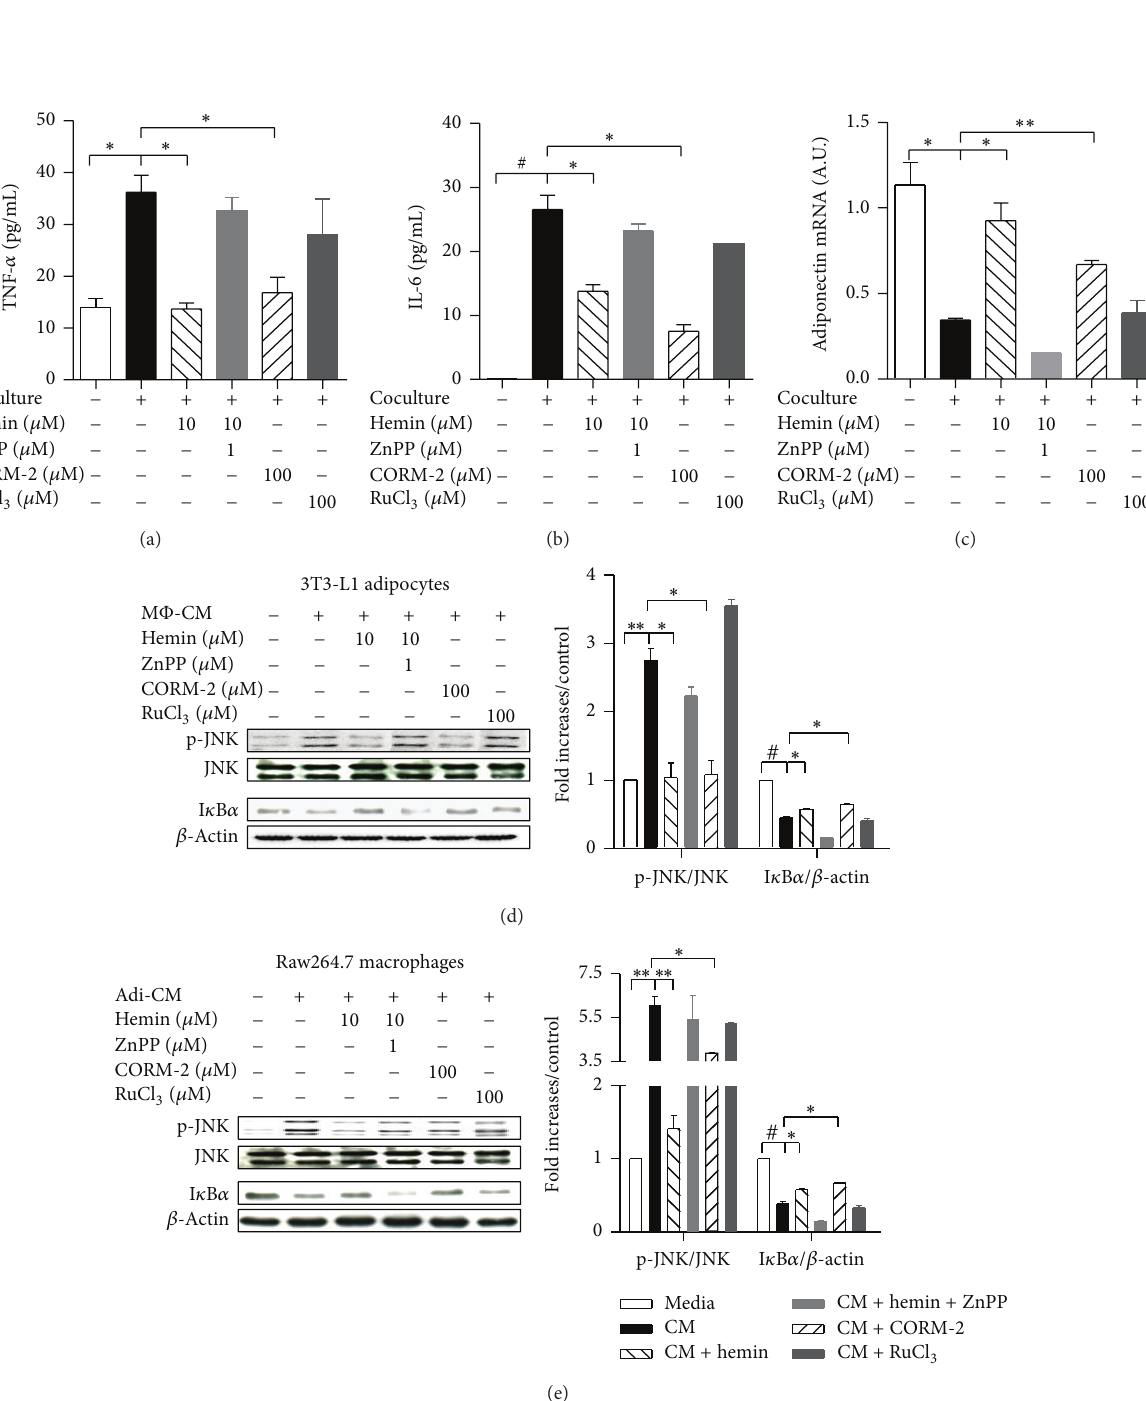
Figure 2: HO-1 induction reduces inflammatory responses in adipocytes and macrophage cocultures. ((a)–(c)) Raw264.7 macrophages were seeded onto 3T3-L1 adipocytes with/without being pretreated with the indicated concentrations of hemin or CORM-2 for 24 h. ZnPP